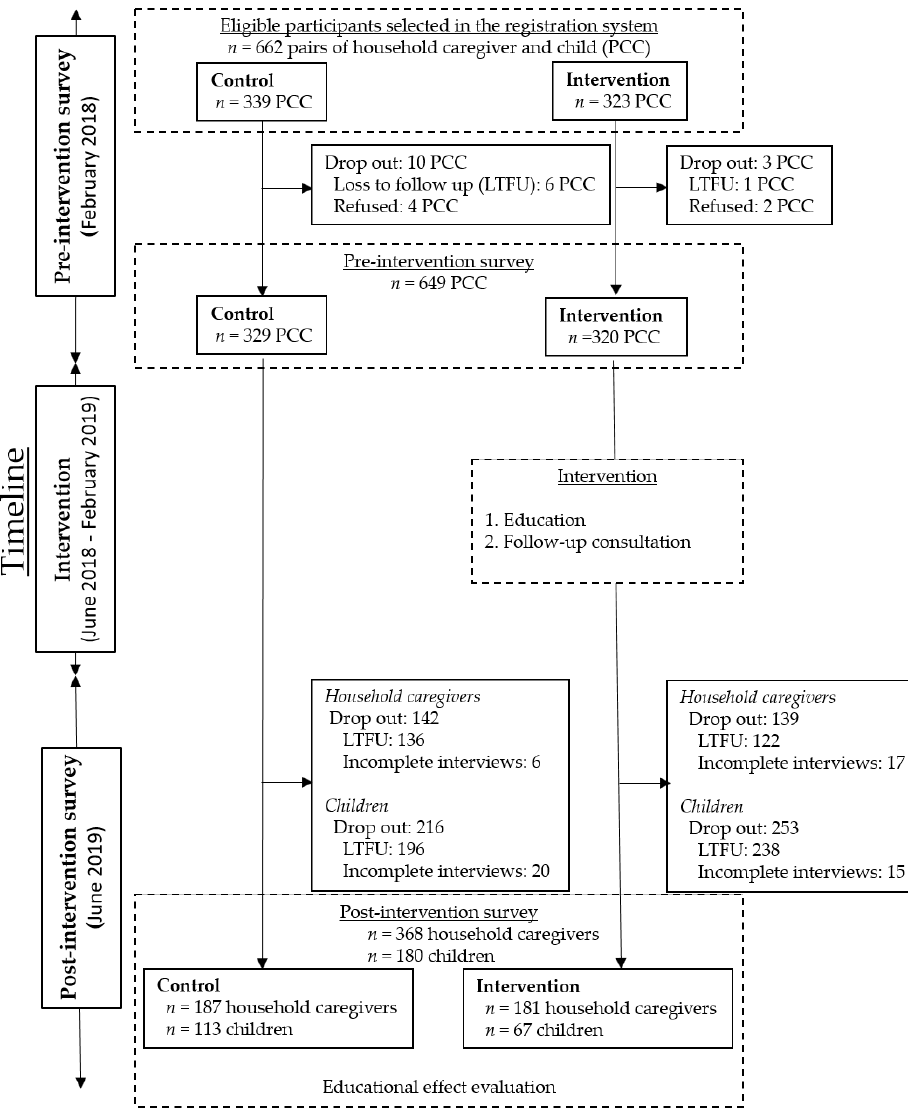
Figure 2. Flow-diagram of enrolled participants and survey procedure. PCC: pairs of caregivers and children; LTFU: lost to follow-up meaning participants were absent at the time of the survey; Incomplete interviews: data contained missing or contradictive